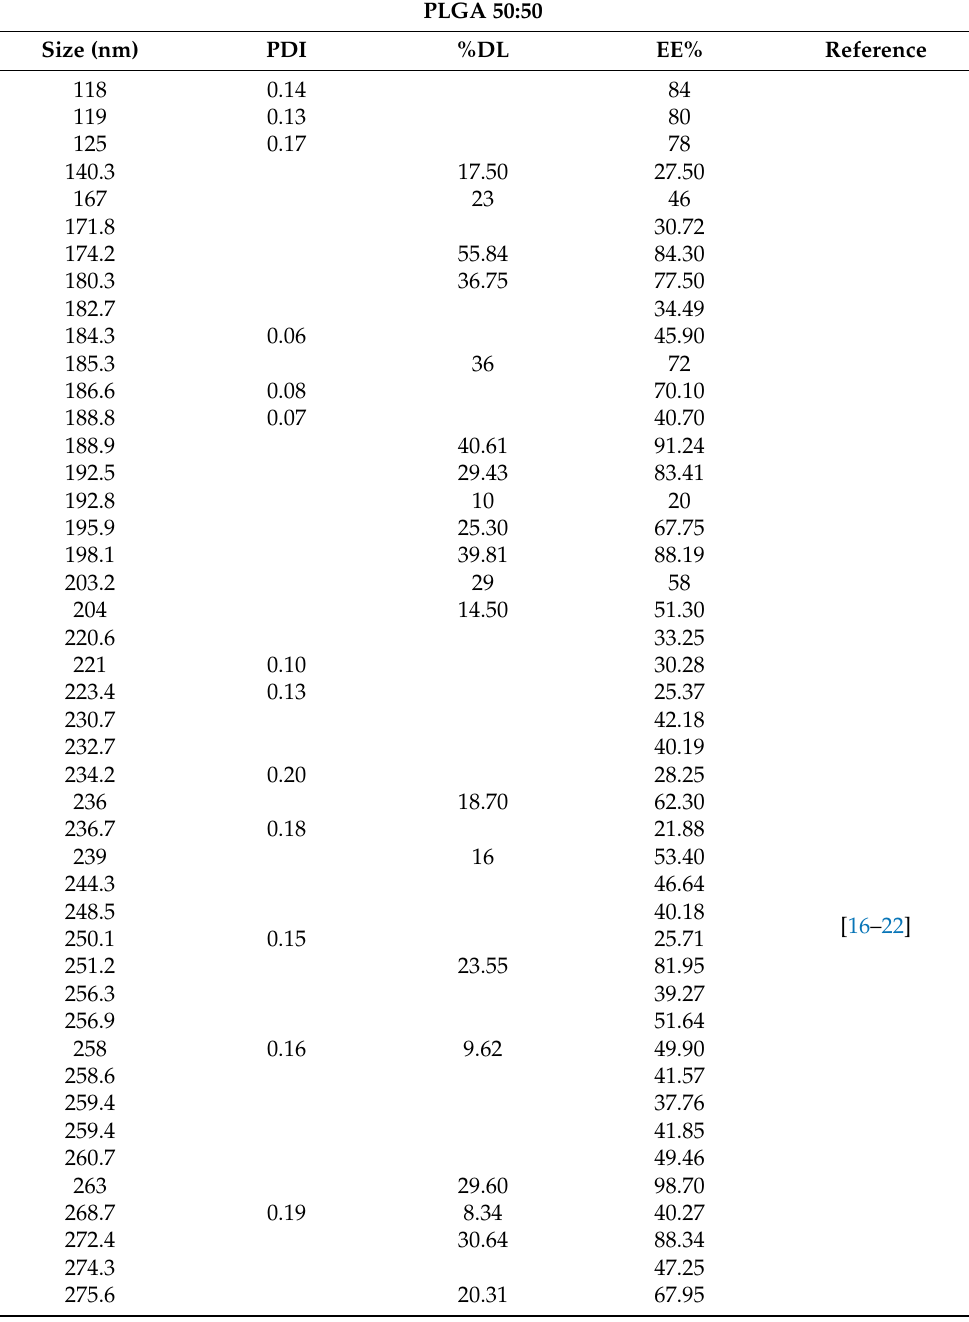
Table 1. PLGA 50:50 nanoparticle data extracted from the